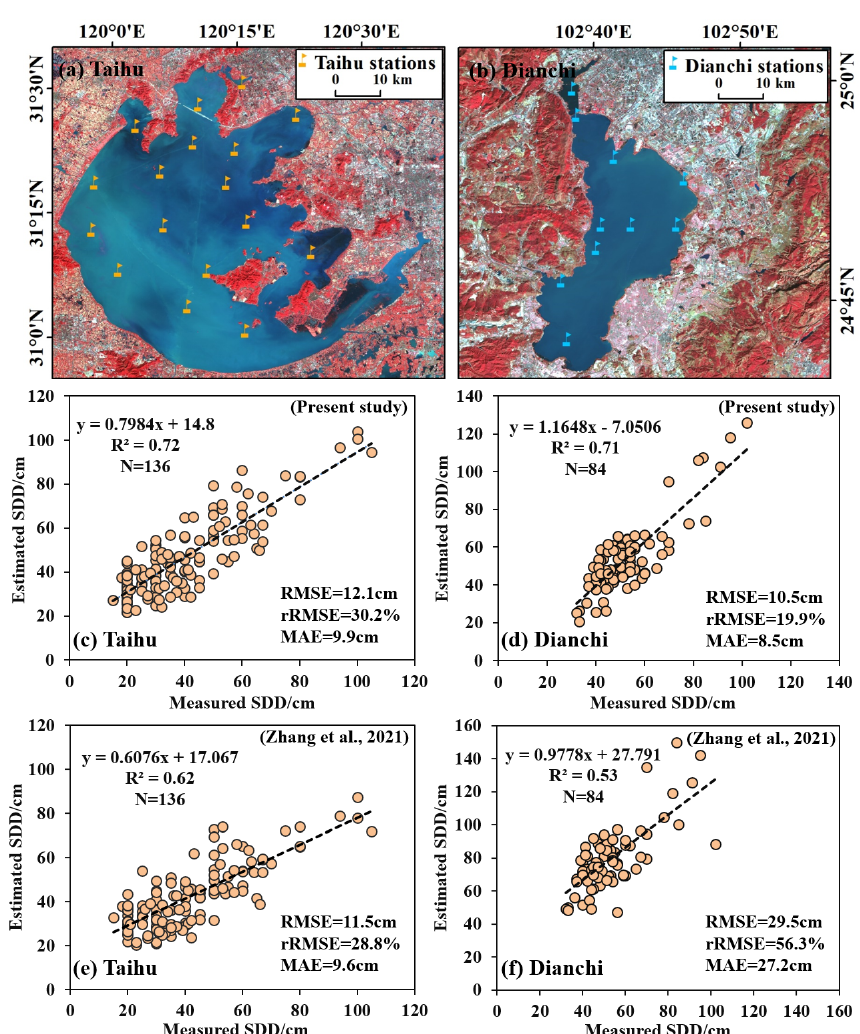
Figure 8. Comparison of different SDD estimation models based on Landsat images within GEE. (a, b) Spatial distribution of monitoring stations located in Lake Taihu and Lake Dianchi, respectively. The Landsat 8 OLI images used in these two panels come from the Geospatial Data Cloud site, Computer Network Information Center, Chinese Academy of Sciences (http://www.gscloud.cn, last access: 5 January 2022). (c–f) The regression line between the measured SDD in Lake Taihu ( N = 136) and Lake Dianchi ( N = 84) during 2019–2020 and estimated SDD values that were obtained from the estimation models developed in this study and Zhang et al. (2021),